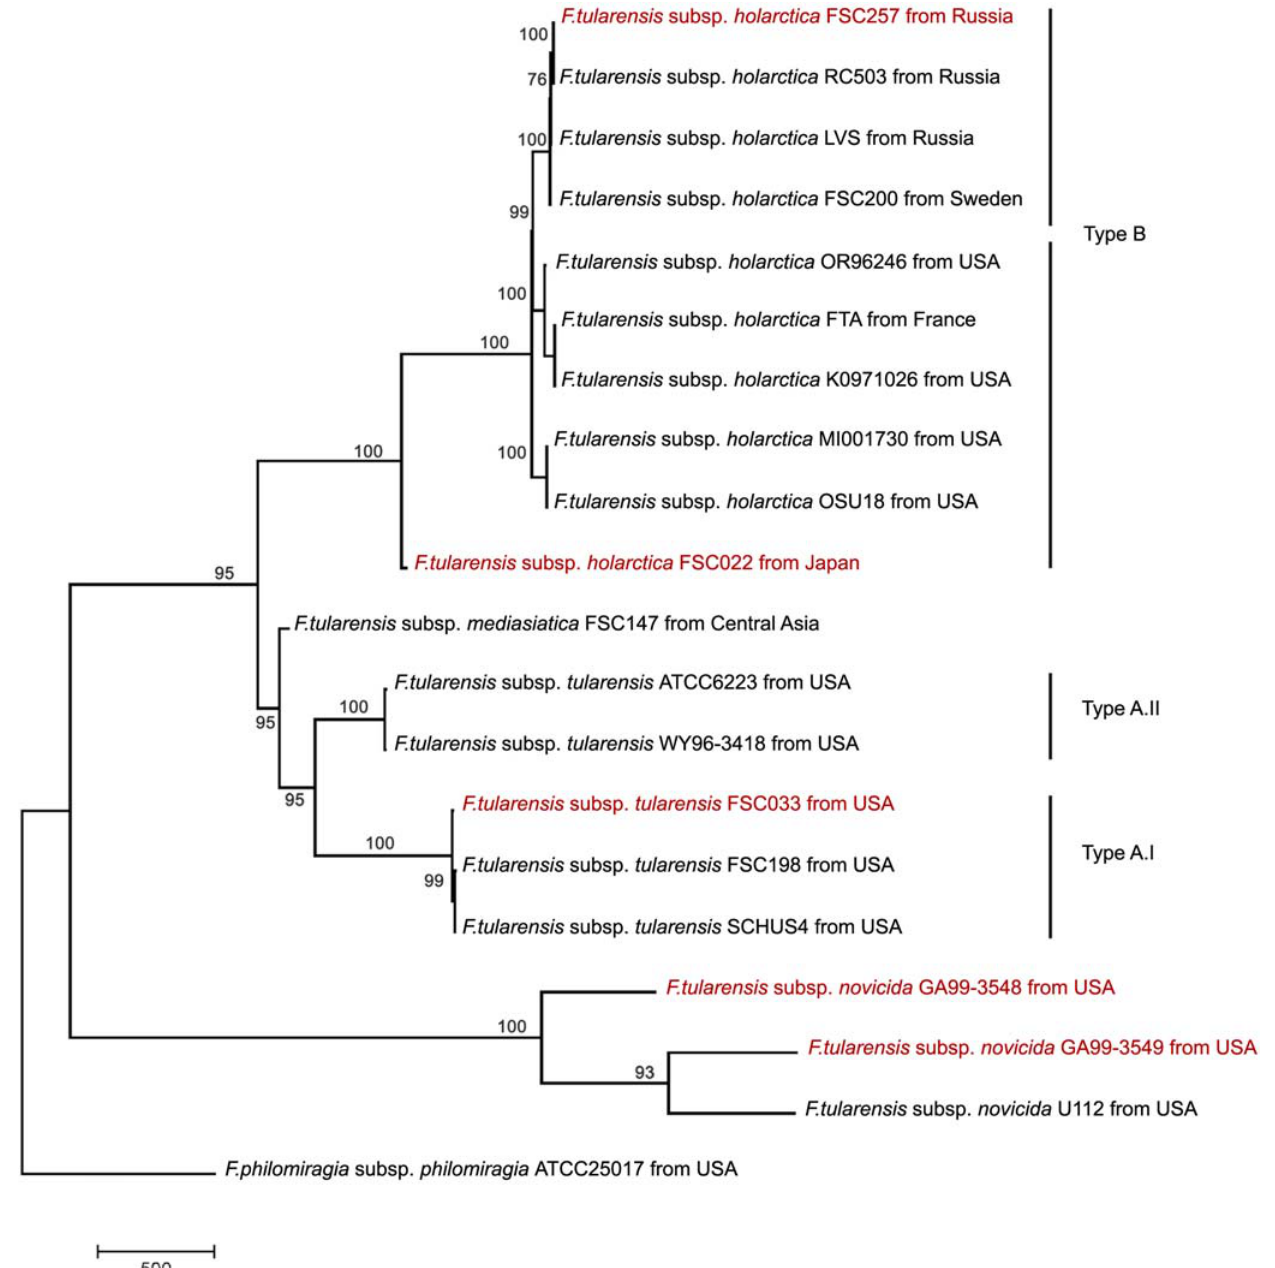
Figure 3. Phylogeny of 20 Francisella strains by analysis of Genome-wide SNP sequences and inferred using Maximum Parsimony method. The evolutionary history of 20 Francisella strains was inferred from analysis of genome-wide SNP sequences. Genome-wide SNPs at least 20 bp apart were selected for further analysis using MEGA4 software. The tree is drawn to scale, with branch lengths calculated using the average pathway method and are in the units of the number of changes over the whole sequence. Francisella strains sequenced at the Broad Institute are in red. The differentiation of F. tularensis subsp. novicida predated differentiation of the more pathogenic F. tularensis subsp. tularensis and F. tularensis subsp. holarctica subspecies from a common ancestor. Our data indicates differential rates of evolution along the Type A.II and Type A.I lineages, as evident from the branch lengths. The Type B FSC022 strain diverged prior to the radiation of the main holarctica group and also has a greatly reduced branch length, consistent with a much slower rate of evolution. The F. tularensis subsp. mediasiatica FSC147 strain is phylogenetically more closely related to the Type A.II lineage even though its pathogenicity is characteristic of Type B strains.